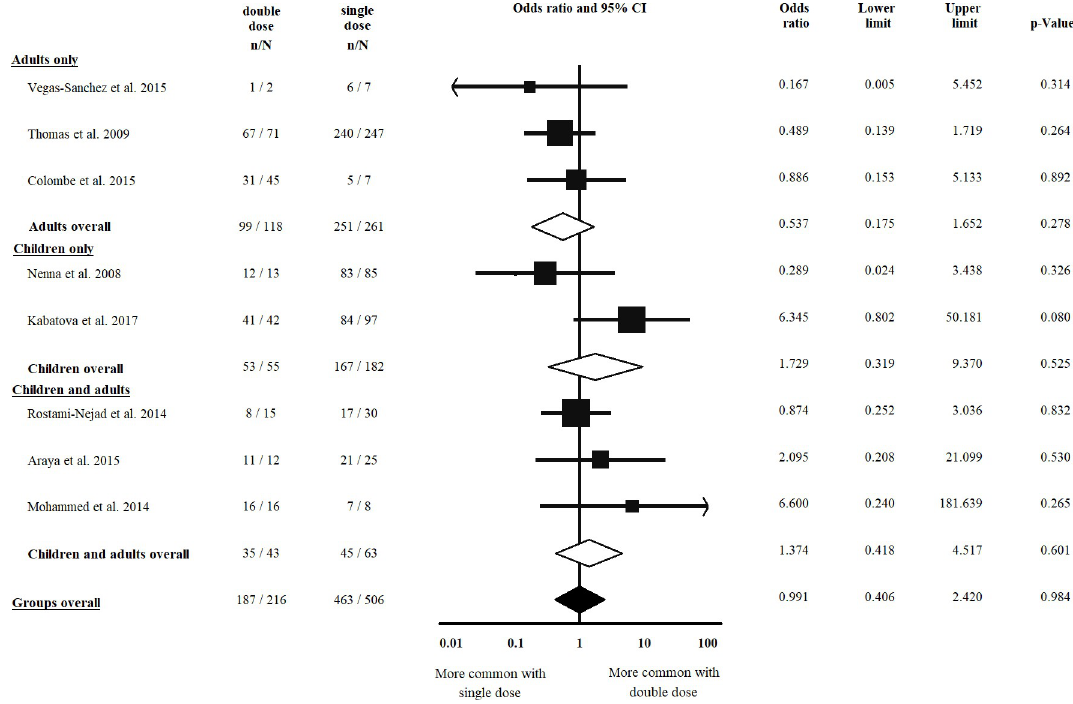
Fig 4. Odds ratios of atrophic histology at diagnosis with double dose vs. single dose of HLA-DQB1 � 02. We failed to detect a significant gene dose effect regarding diagnostic histology. Heterogeneity of the groups overall: I 2 = 11.8%, p = 0.338; heterogeneity of the subgroup of adults: I 2 = 0.0%, p = 0.682; heterogeneity of the subgroup of children: I 2 = 71.6%, p = 0.061. CI: confidence interval.